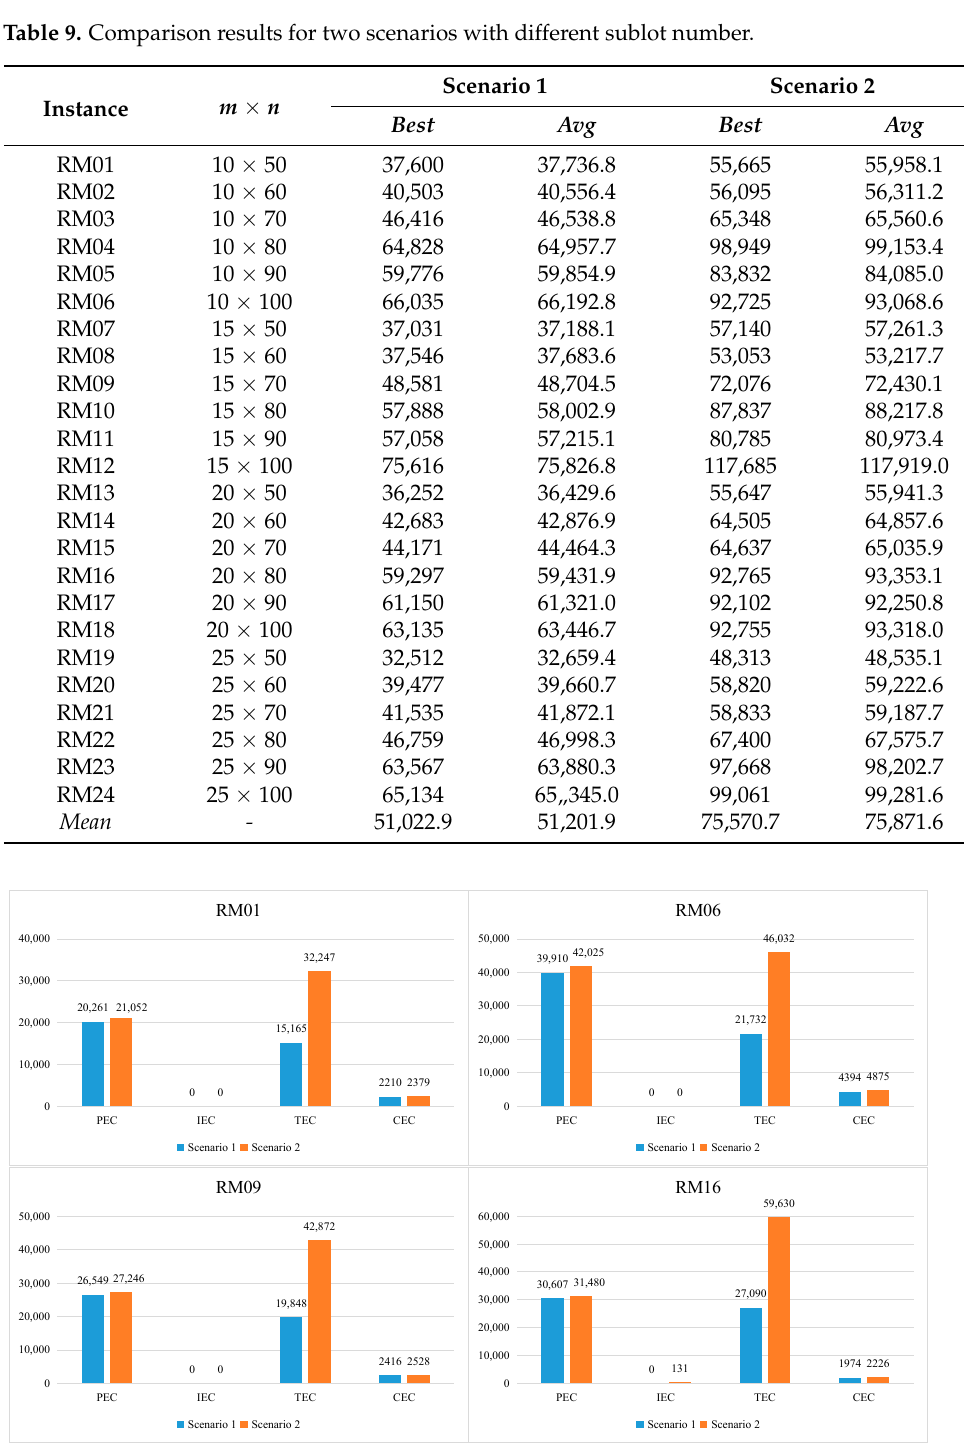
Figure 9. The histograms in the two scenarios of sublot number. Table 9. Comparison results for two scenarios with different sublot number.